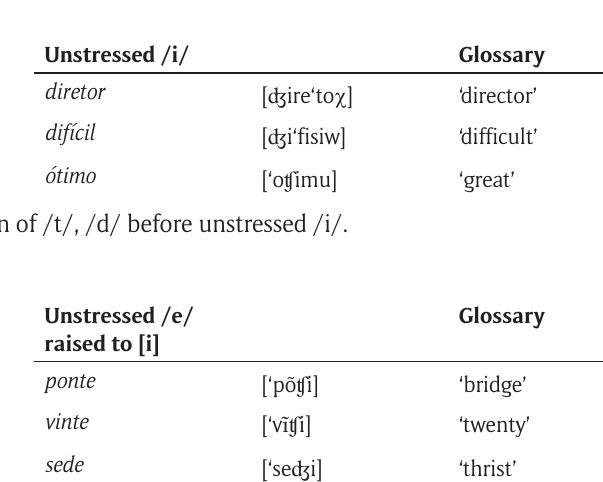
Table 4: Palatalization of /t/, /d/ before unstressed /e/ raised to [i].